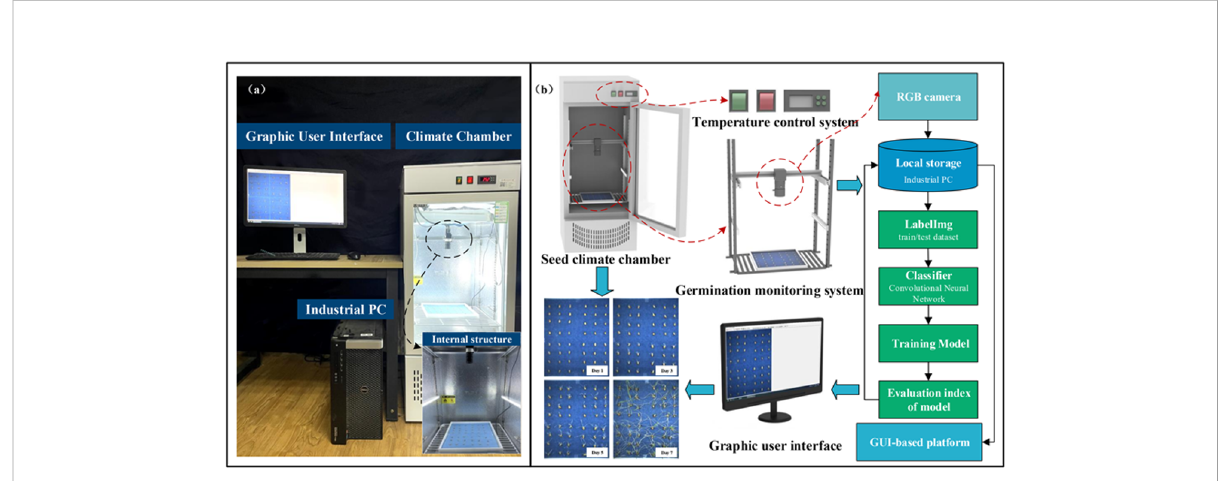
FIGURE 1 WSVAS hardware platform for real-time monitoring of seed